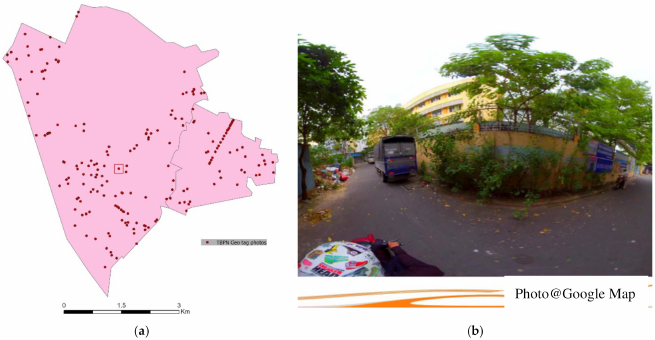
Figure 11. IGSs in Tan Binh’s hotspots ( a ) and a GSV image ( b